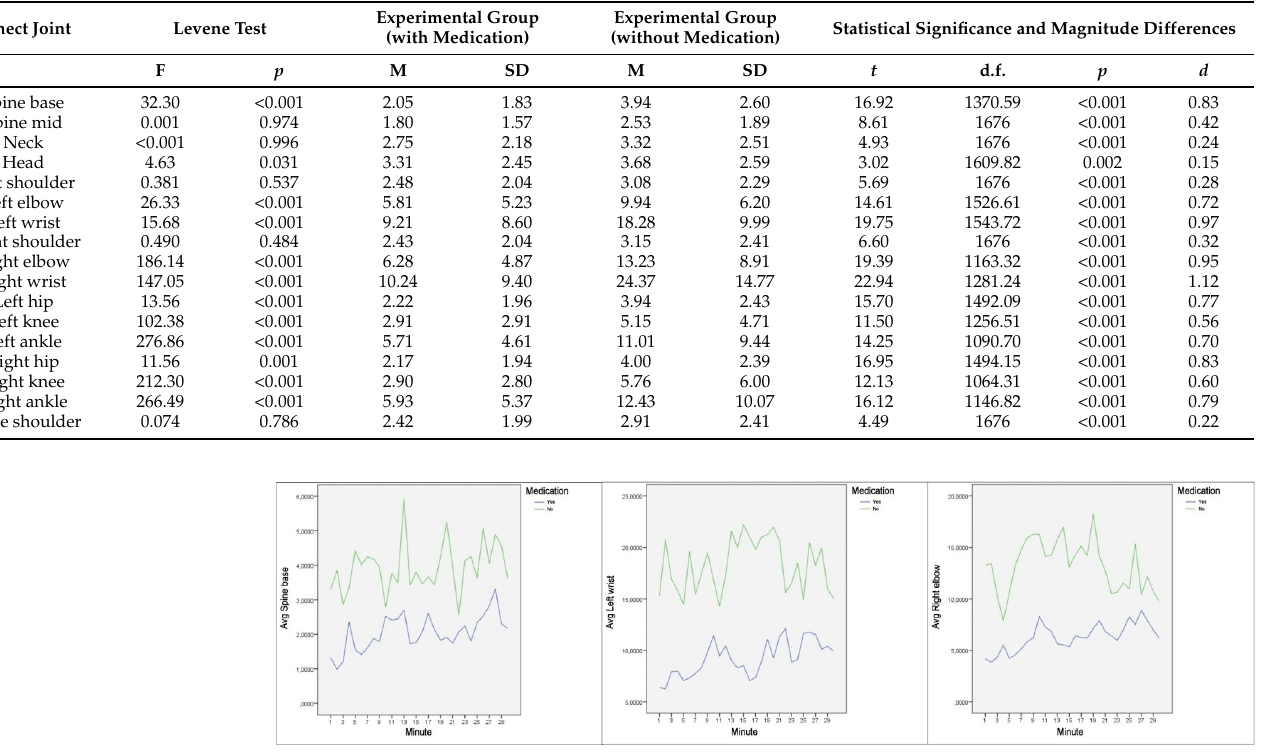
Figure 2. Average movement per minute for spine base ( left ), left wrist ( center ) and right elbow ( right